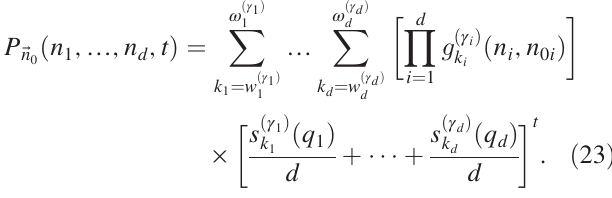
δ . The open circles n 1 ; 5 n 2 ; 5